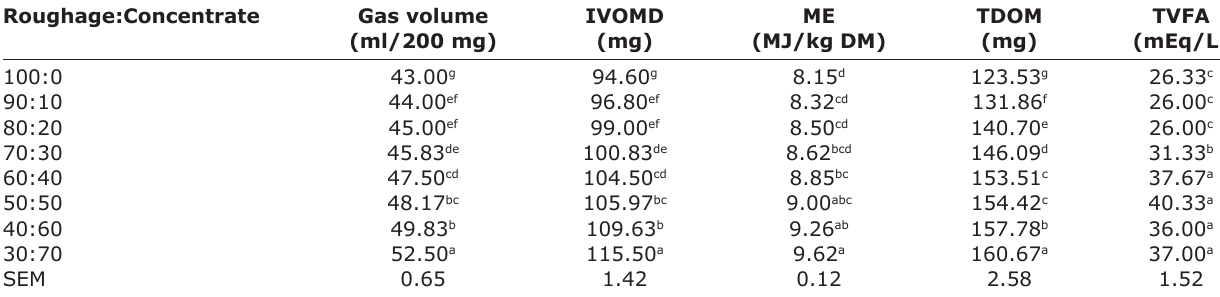
Table-3: Effect of MS to concentrate ratio on in vitro gas production parameters in Deccani sheep. Roughage:Concentrate